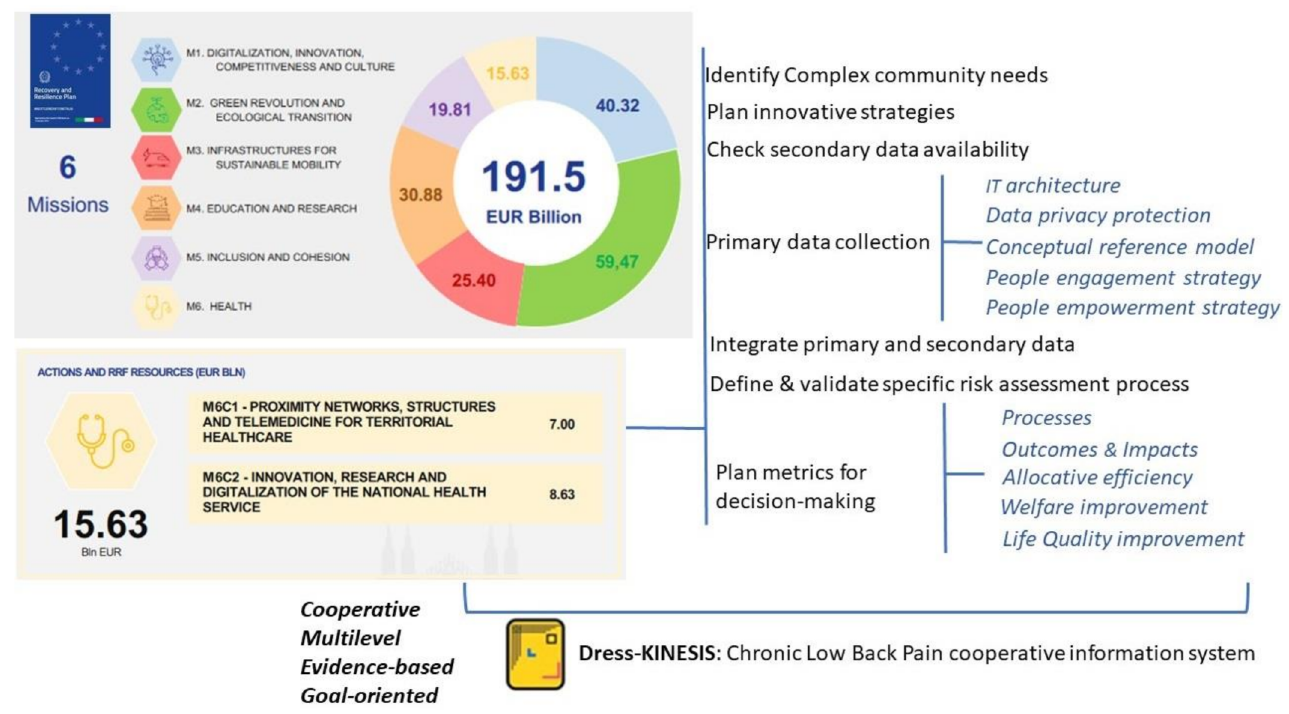
Figure 1. Article